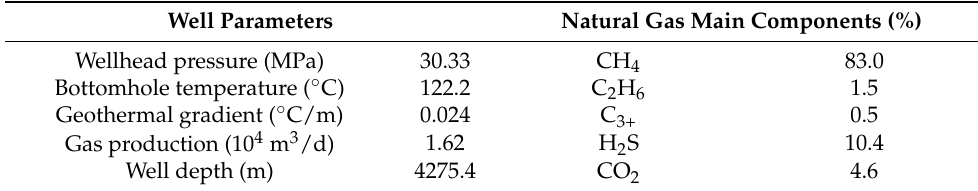
Table 1. Gas-well and produced natural-gas parameters.